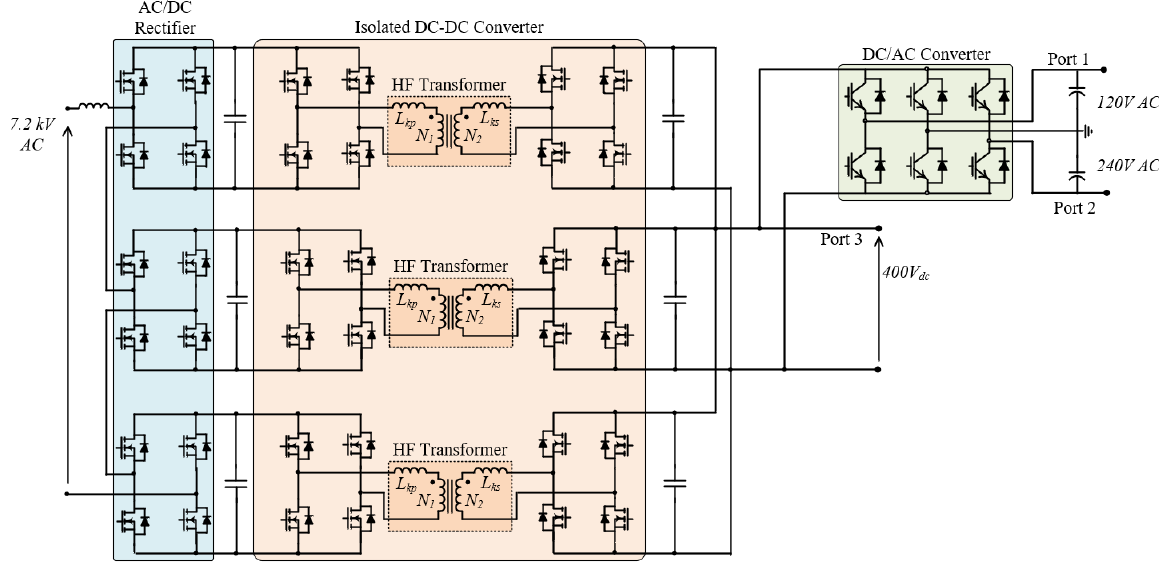
Figure 4. FREEDM Gen-1 solid-state transformer topology.